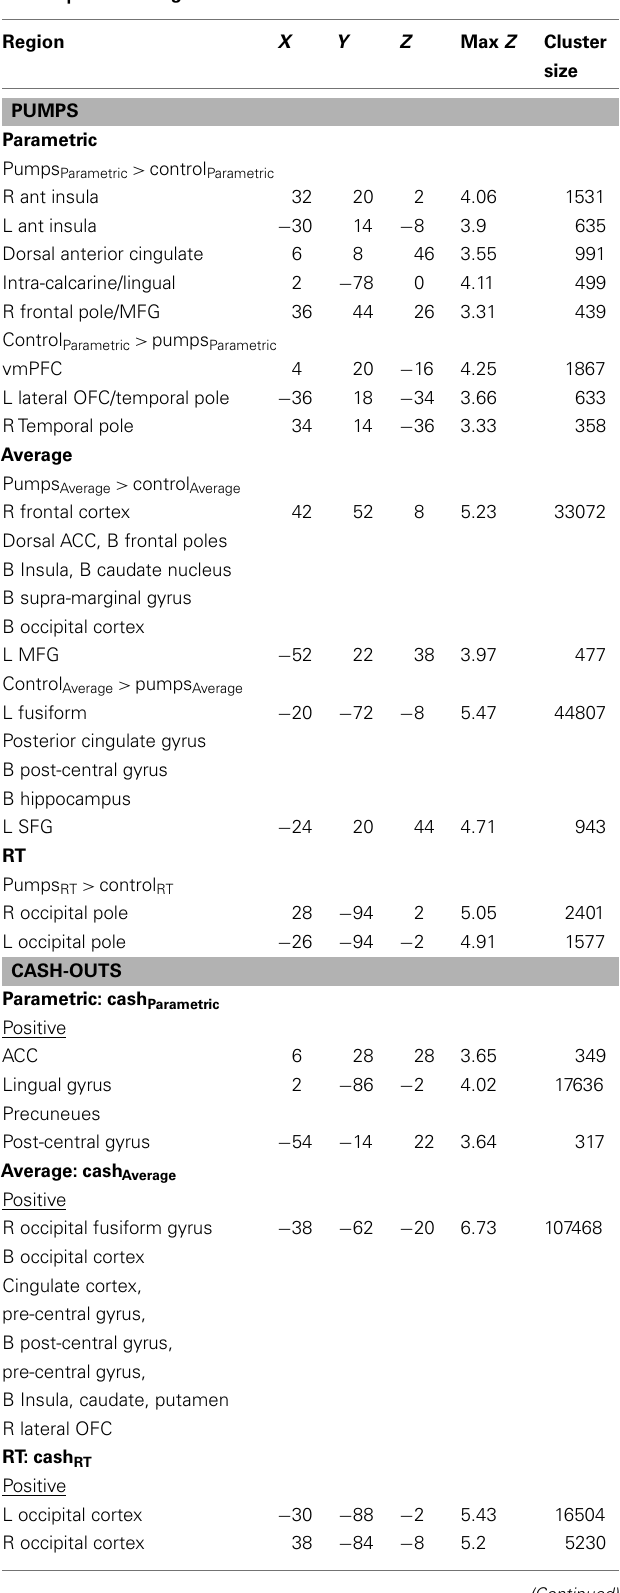
Table 2 | Peaks of significant clusters of